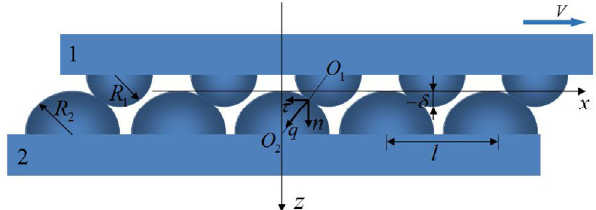
Fig. 4 Sliding scheme of two regular rough